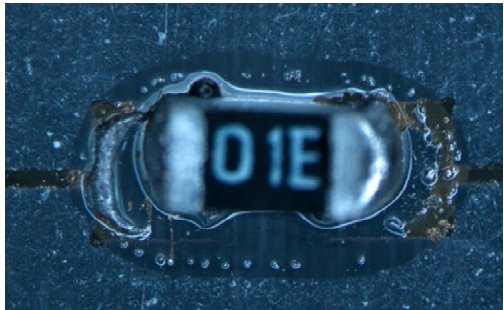
Figure 10. Aerosol jet printed Ag structures (ink: Sicrys I30 EG-1) on 2D test substrate (Luxaprint 3D mold) after soldering with SnBi solder in reflow oven with peak temperature of 180 °C.